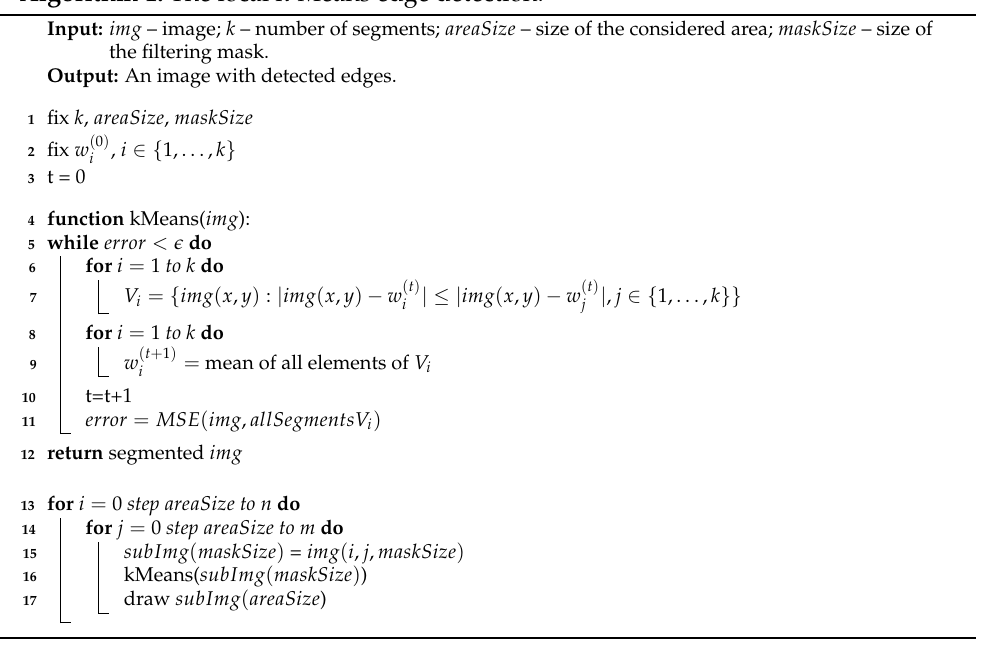
Figure 4. The sample filter masks: ( a ) a point mask of size 5 × 5 pixels, used for i.e., Canny algorithm, ( b ) an area mask of size 8 × 8 pixels, with the area size of 4 × 4 pixels, used for the proposed local k-Means. Algorithm 1: The local k-Means edge